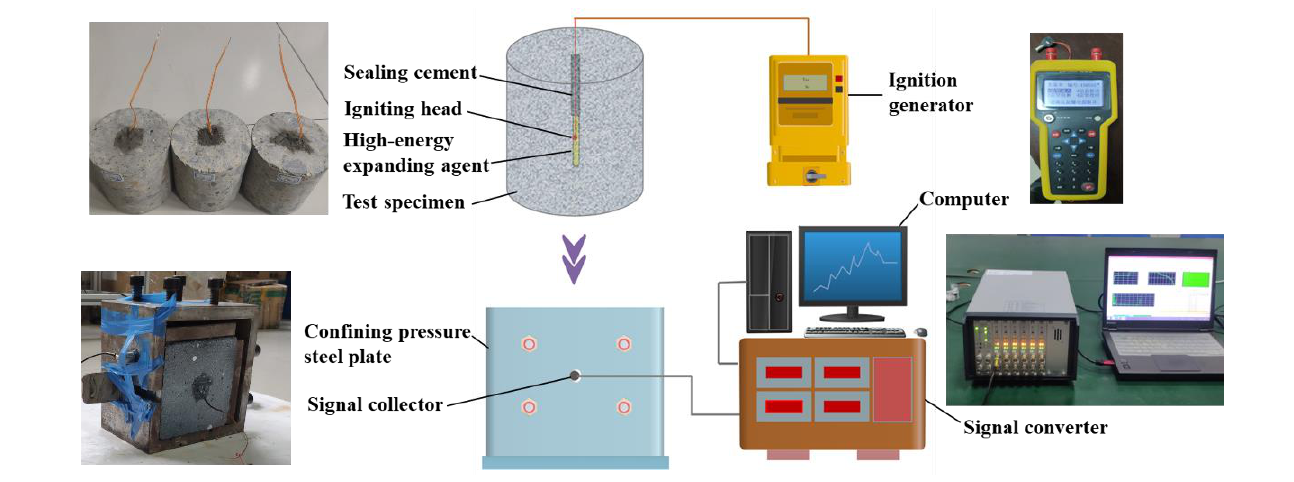
Table 2. Mechanical parameters of concrete specimens.